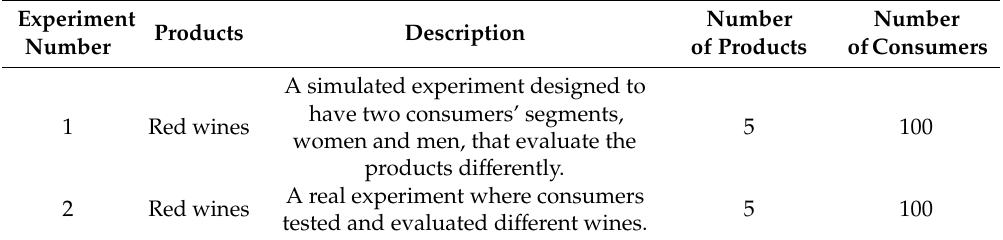
Table 1. Experiments.